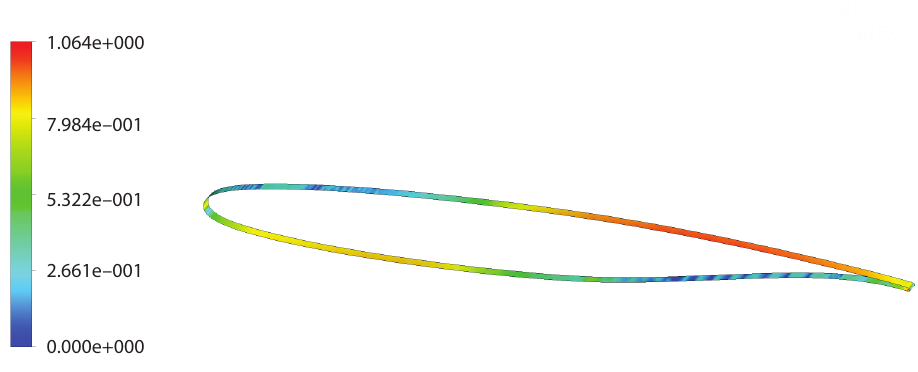
Figure 10. Y + calculated on the airfoil